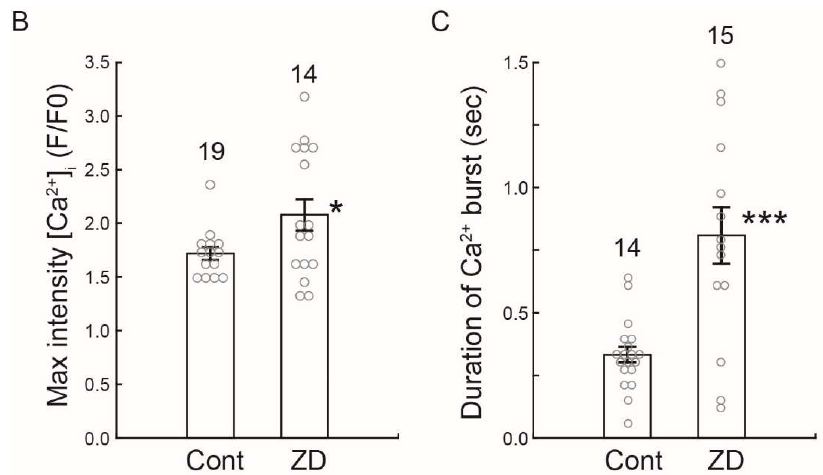
Figure 7. Effects of an HCN channel inhibitor ZD7288 on intracellular Ca 2+ dynamics during sperm chemotaxis. ( A ) Trajectories of the sperm head (Upper) and changes in [Ca 2+ ] i signals yielded by the sperm tail (Lower) in ASW (control) or treated with 100 µ M ZD7288 around the tip of a capillary containing 1 µ M SAAF. The origin of the coordinates indicates the capillary tip. The arrows indicate the swimming direction of the sperm. The dots show the head position with the color representing the average intensity of [Ca 2+ ] i signals obtained from sperm tail in pseudocolors of the LUT. The color scale is the LUT for fluorescence signals. ( B , C ) Maximum of [Ca 2+ ] i ( B ) and duration of [Ca 2+ ] i increase ( C ) around the tip of a capillary containing 1 µ M SAAF in sperm tail in ASW (control) or treated with 100 µ M ZD7288. [Ca 2+ ] i is expressed as F/F0, which is the value of the fluorescent intensity from head (F) divided by the average intensity of basal [Ca 2+ ] i before SAAF stimulation emitted by the heads (F0). The values are expressed as mean ± S.D. Total